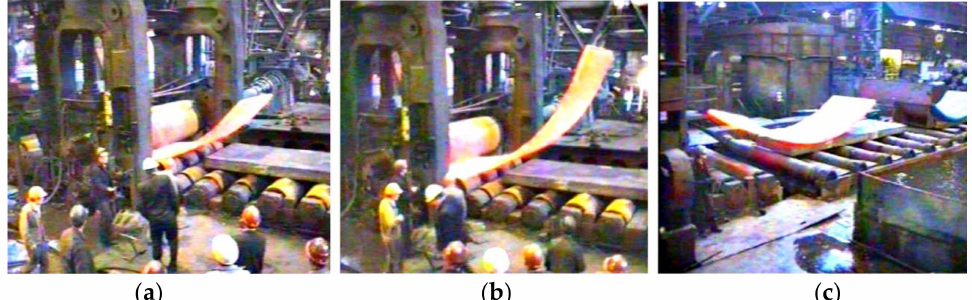
Figure 8. Industry testing on hot plate mill 4500 at OJSC Magnitogorsk Iron and Steel Works: ( a , b ) Combined process of asymmetric rolling and plastic bending; ( c ) finished curved plate.